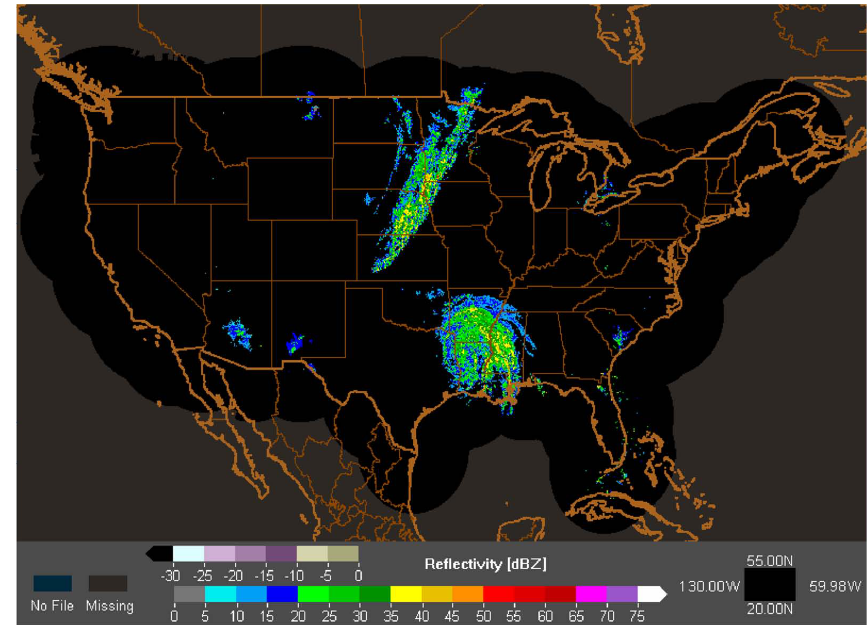
Fig. 1. NEXRAD National Radar Reflectivity mosaic (in dBZ) on 2 September 2008 at 12:00UTC. We can observe the signature of Hurricane “Gustav” covering Louisiana, Mississippi and